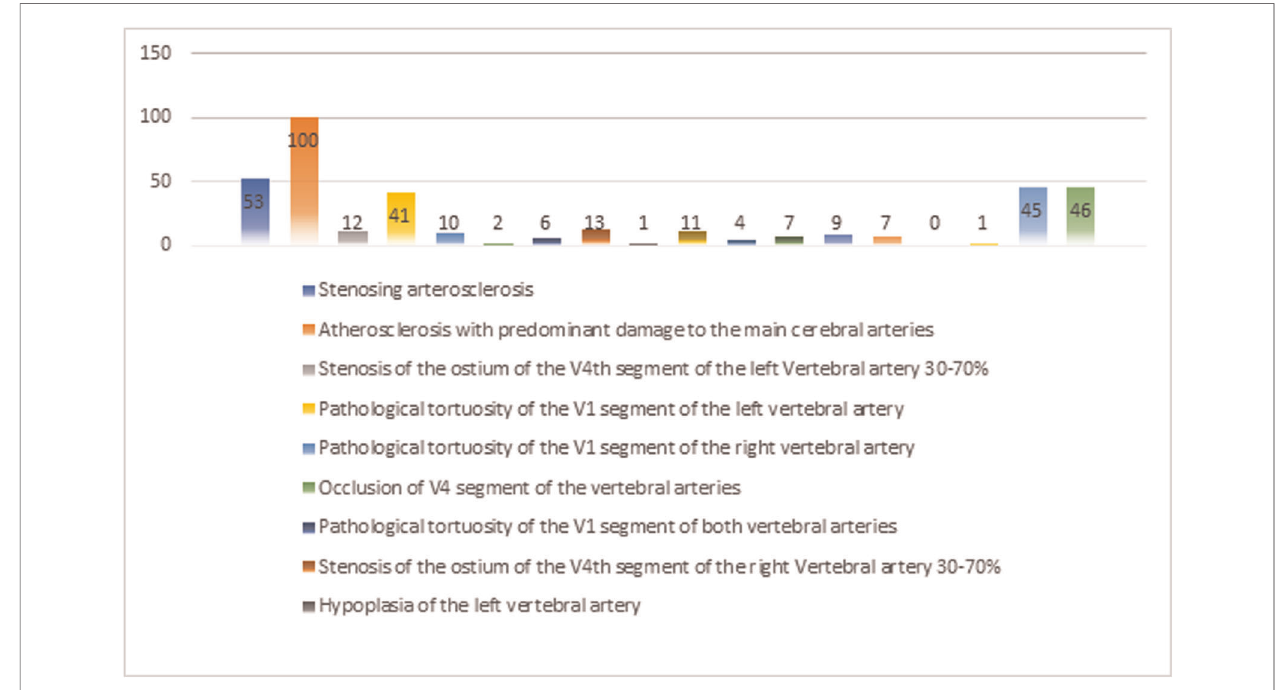
FIGURE 1 | Clinical diagnosis (in % of the